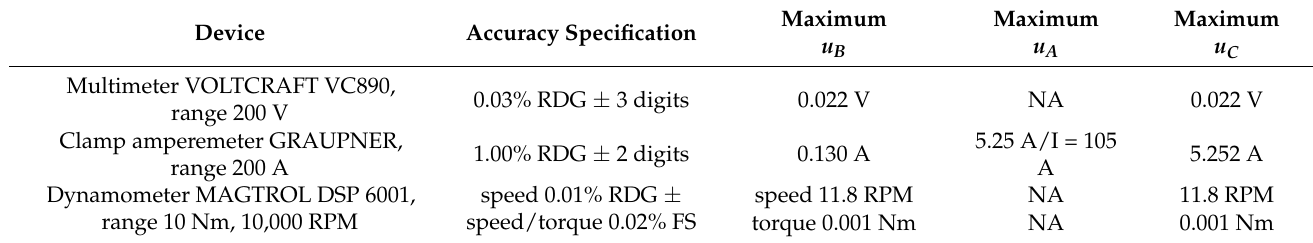
Table 4. Experimental setup, its accuracy, and the evaluated uncertainty.